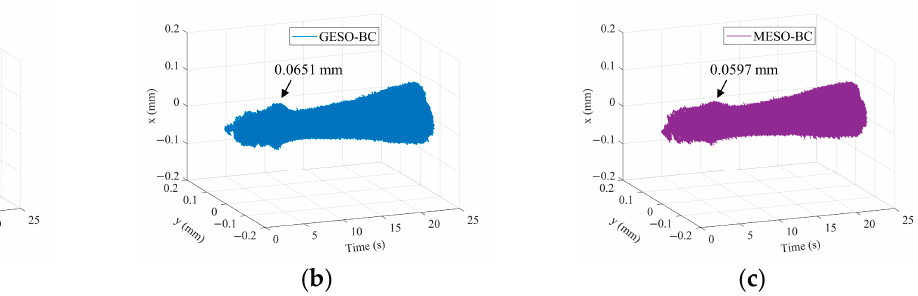
Figure 13. Response waveforms under 6 N sinusoidal disturbance experiments: ( a ) Rotor dis- placement; ( b ) control voltage.